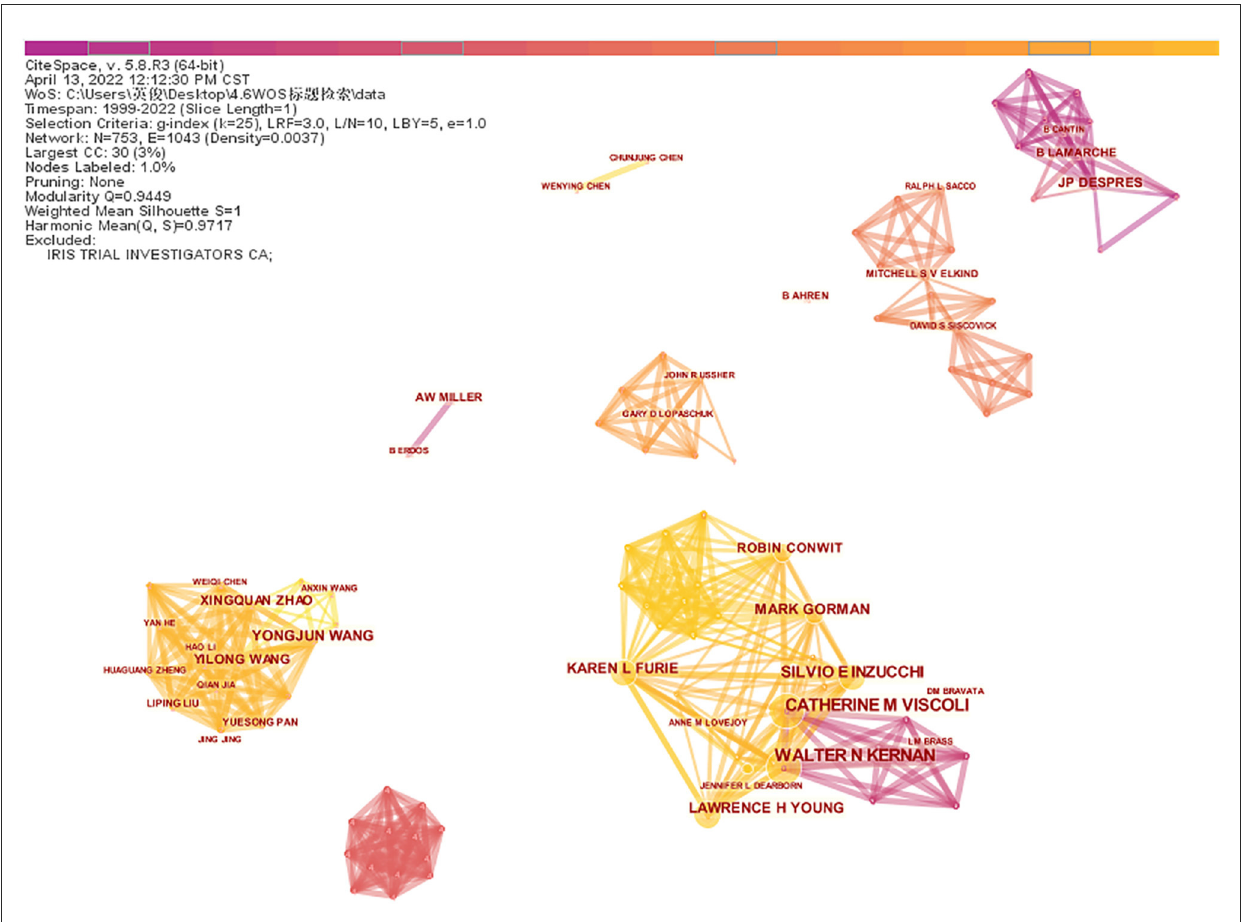
FIGURE3 The network of